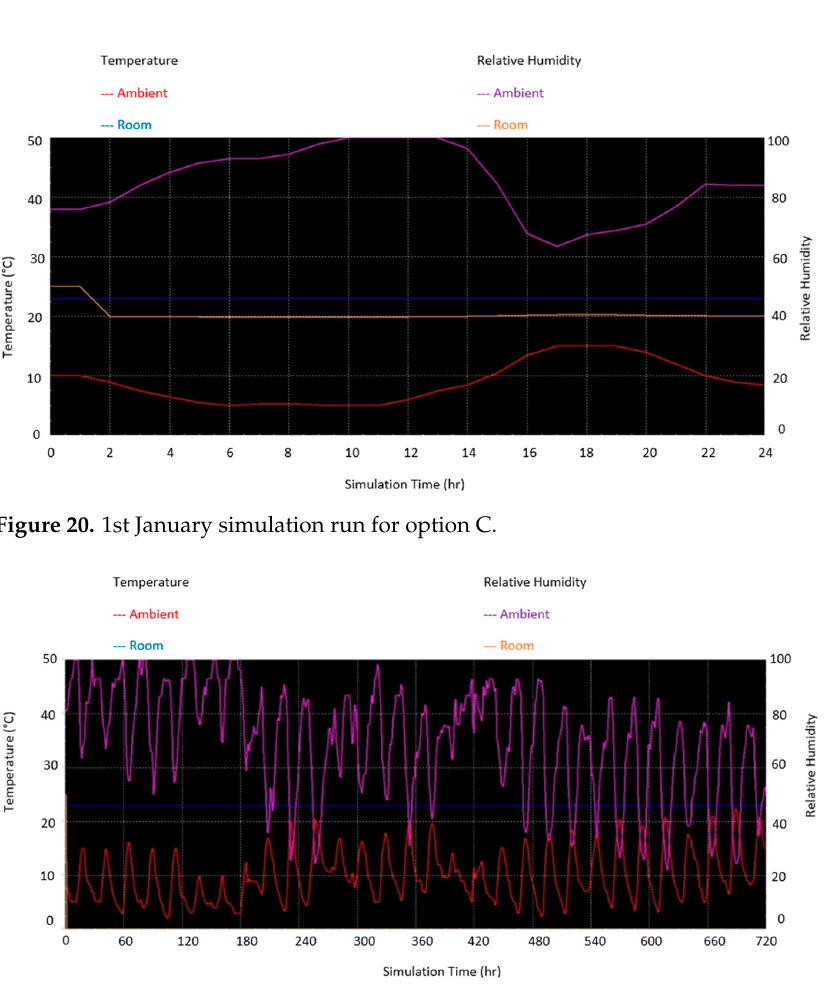
Figure 21. January month simulation run for option C.